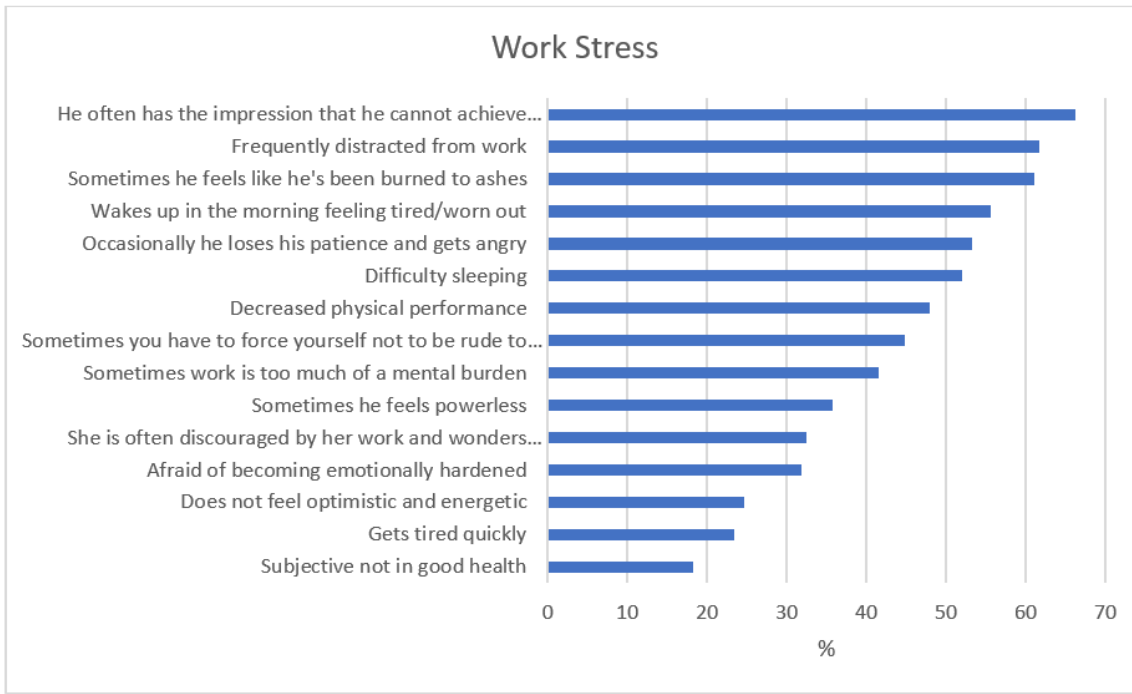
Figure 1. Participants’ answers regarding workload, as percentages ( n = 154).